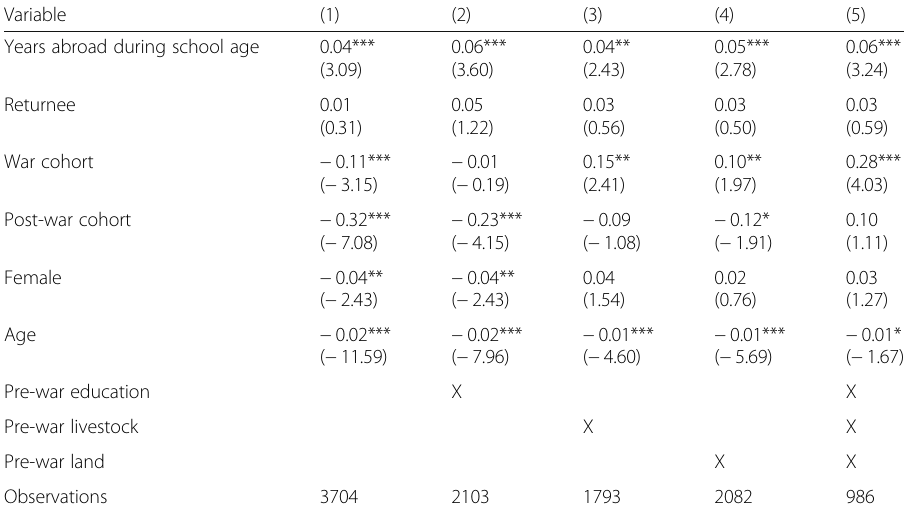
Table 5 Impact of years abroad during school age on the likelihood of finishing primary school Variable (1) (2) (3)